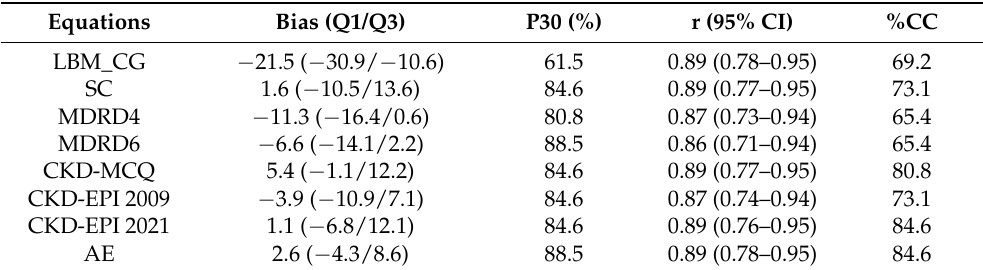
Table 4. Performance of the different equations to estimate the mGFR in the TVS ( n = 26). Equations